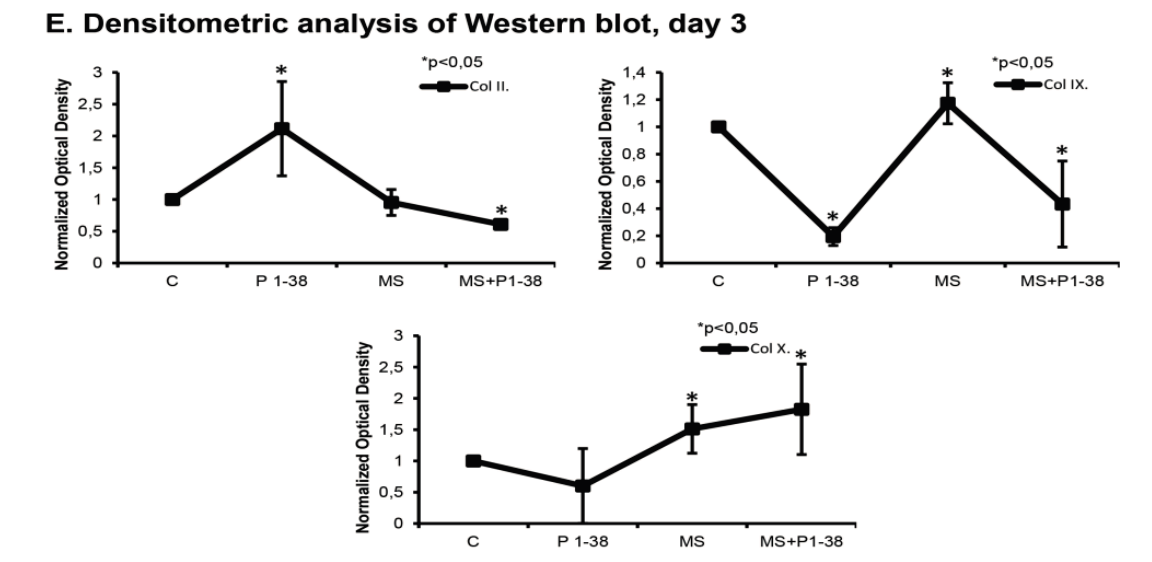
Figure 2. PACAP and/or mechanical load altered the collagen production of HDC. PACAP 1–38 at 100 nM was applied continuously from day one. Short time, transient MS, was applied on days two and three for 30 min on both days. ( A ) Collagen production of HDC was determined by 3 H-collagen incorporation; ( B ) RNA expression of collagen type II ( Col2a1 ), collagen type IX ( Col9a1 ) and collagen type X ( Col10a1 ) on day three. GAPDH was used as a control; ( D ) Protein expression of collagen type II, collagen type IX, collagen type X on day three. Actin was used as a control. For panels ( B , D ) numbers below signals represent integrated densities of signals determined by ImageJ software. Representative data of three independent experiments are shown; ( C , E ) Statistical analysis of RT-PCR and Western blot data. All data presented are the averages of at least three different experiments. Statistical analysis was performed by Student’s t -test. All data were normalized on GAPDH/Actin and data are expressed as mean ± SEM. (C, control; P1–38, PACAP 1–38; MS; mechanical stimulus). Statistically significant difference between collagen production rate of cells in cultures that received the loading regime and/or PACAP 1–38 vs. control cultures is marked by asterisk (* p < 0.05) in all